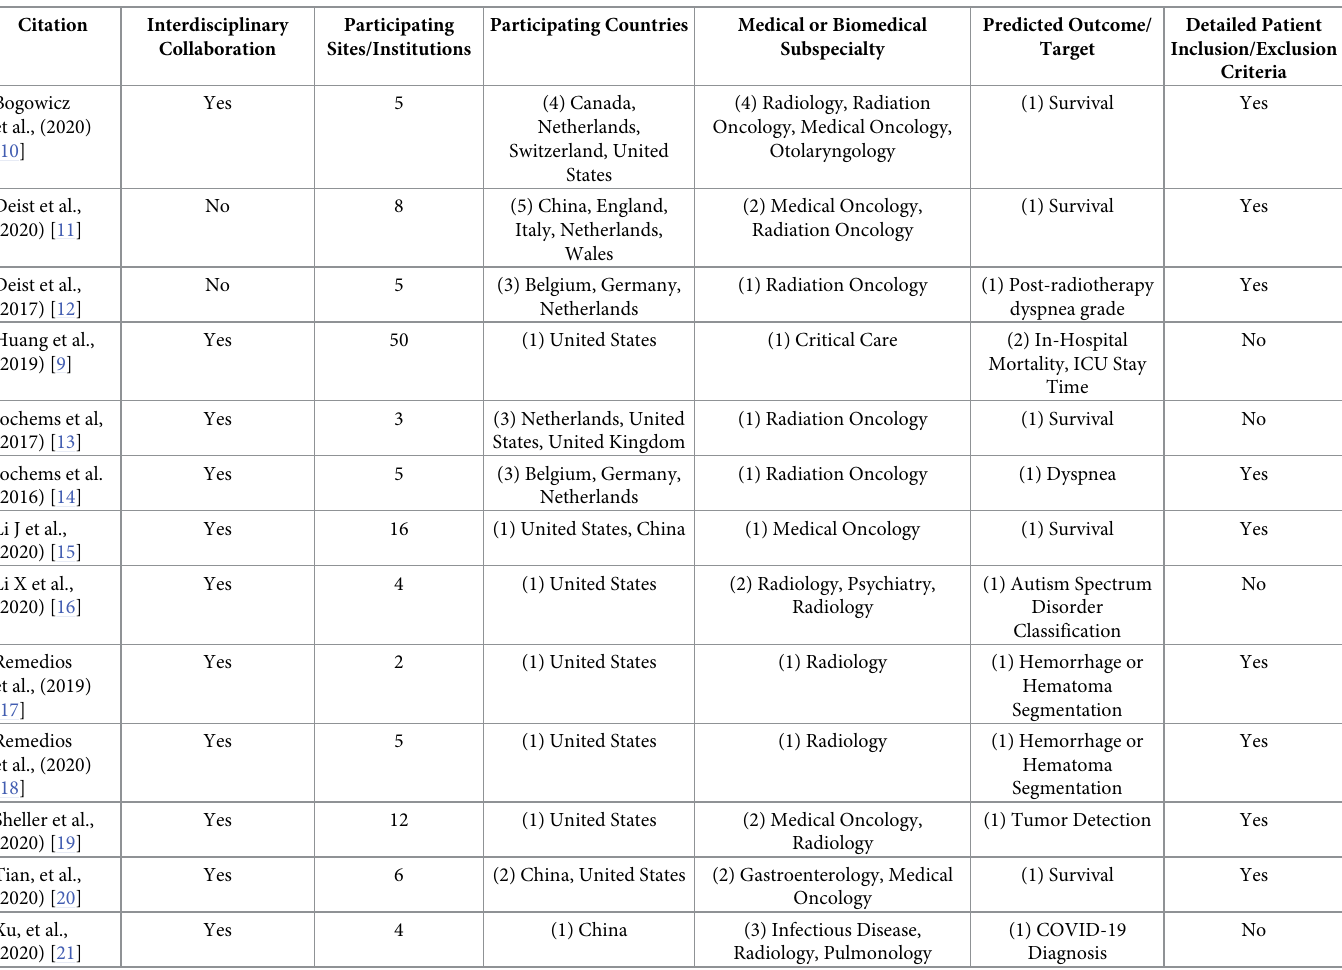
Table 1. Basic characteristics of included